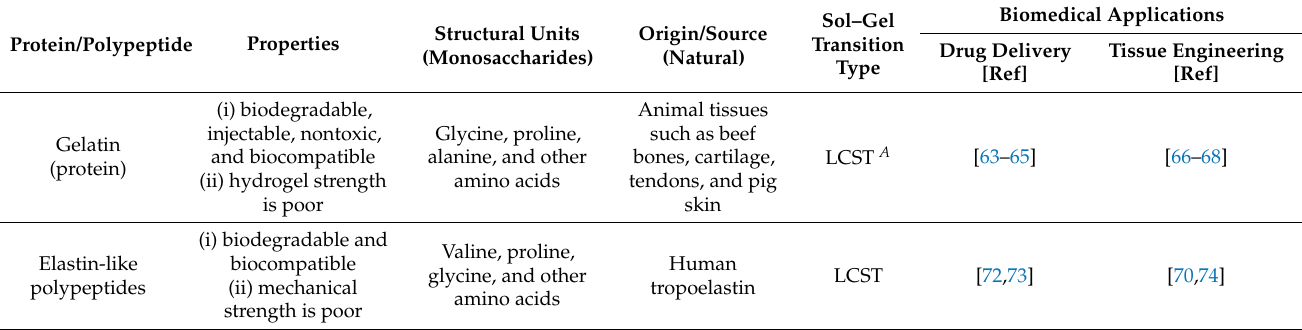
Table 2. The sol–gel transition type and biomedical applications of thermo-responsive protein/polypeptide-based hydrogels.